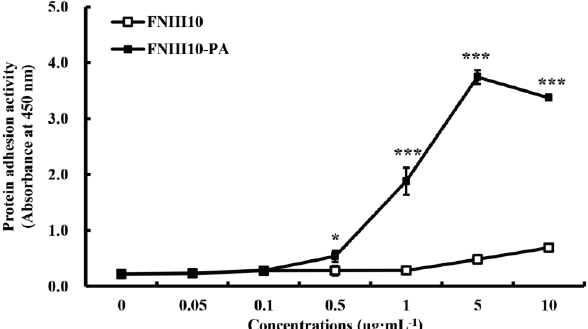
Figure 2. Protein adhesion activity of FNIII10-PA. Twenty-four well plates were coated with various concentrations of FNIII10 or FNIII10-PA overnight at 4 °C. After the addition of antibody, Turbo-TMB ELISA was added. Protein adhesion activities are expressed as mean ± SD ( n = 3). * p < 0.05 and *** p < 0.001.